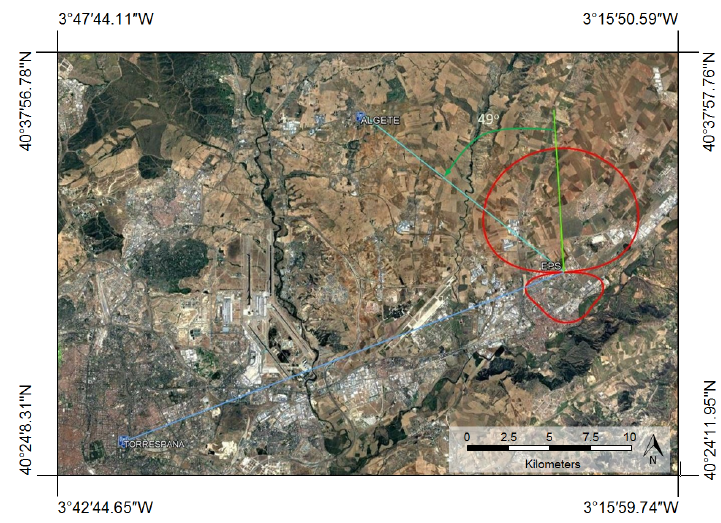
Figure 16. Radar scenario located at the roof of the Superior Polytechnic School of Alcalá